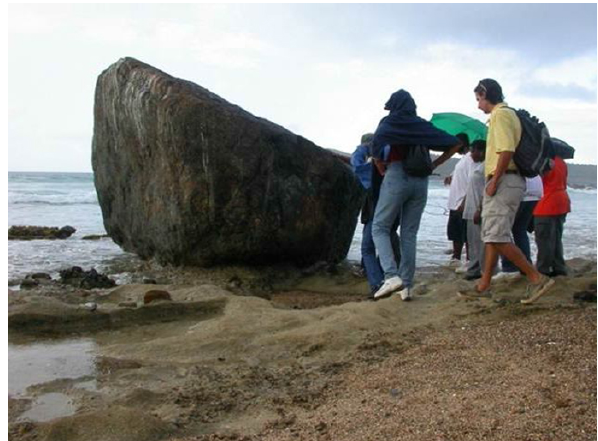
Fig. 6. Science 100 students examining tsunami deposits. This boul- der is hypothesized to have been deposited on the St. Thomas north shore by a tsunami (P. Mills photo,